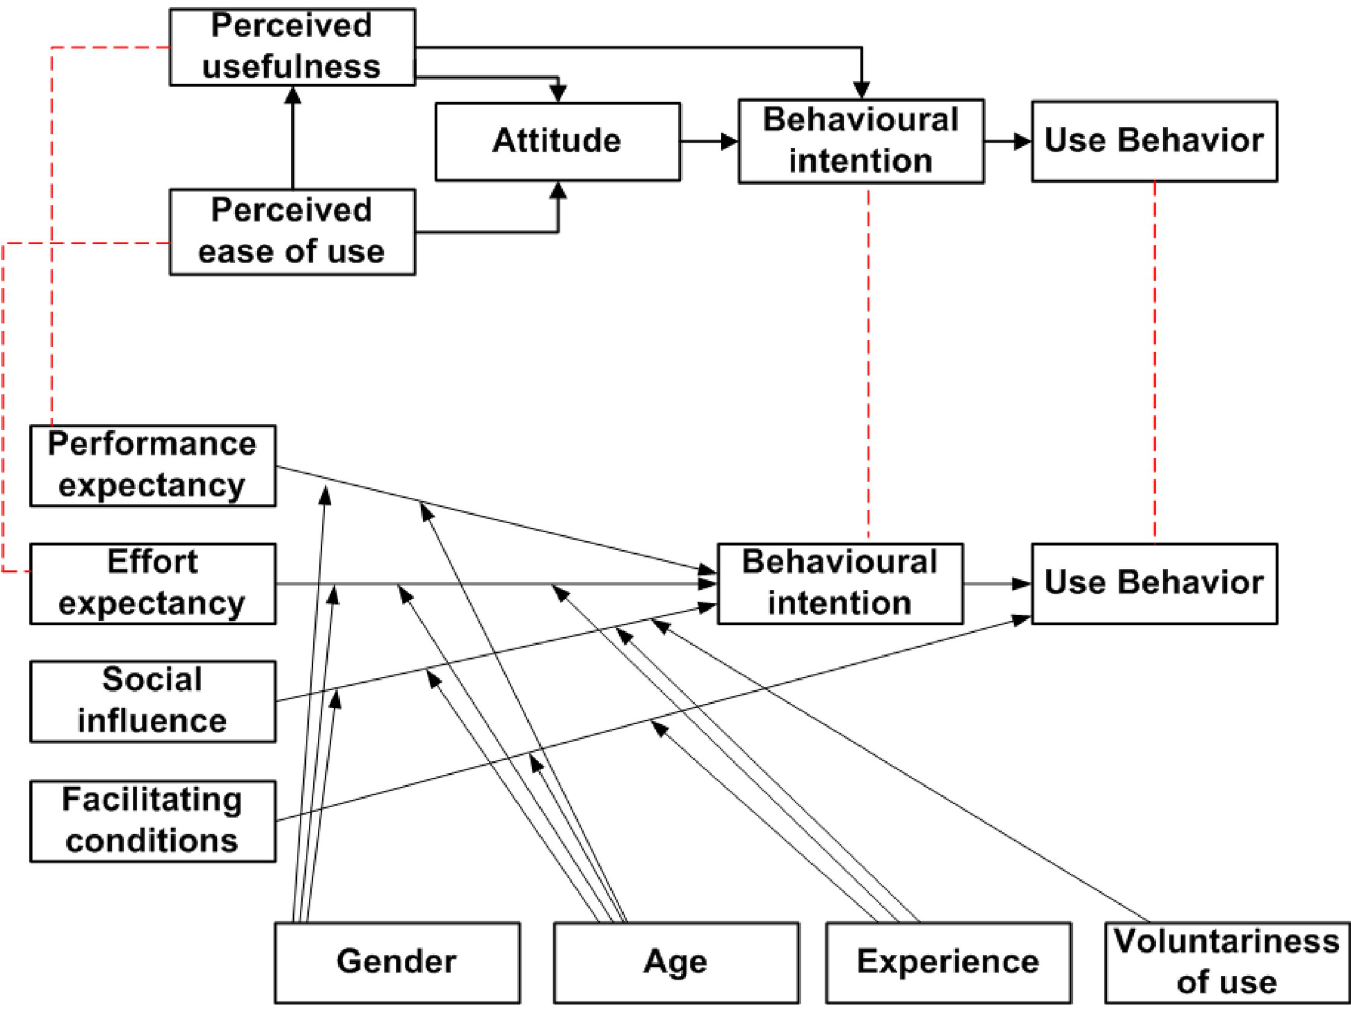
Fig 3. Comparison between the TAM and UTAUT models